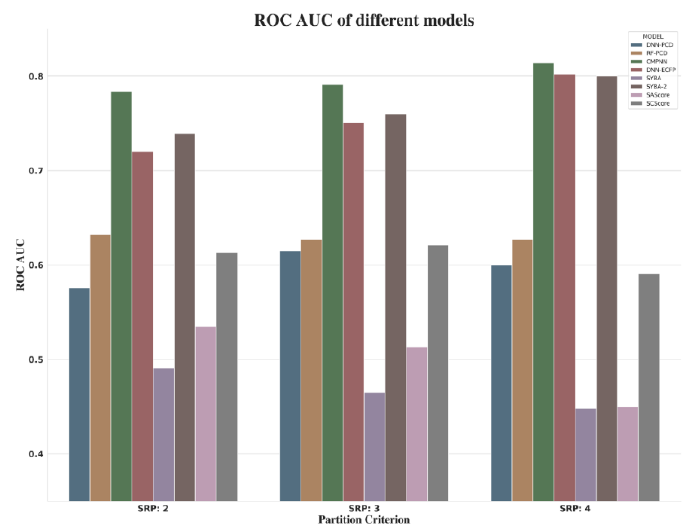
Figure 11. ROC AUC of different models.